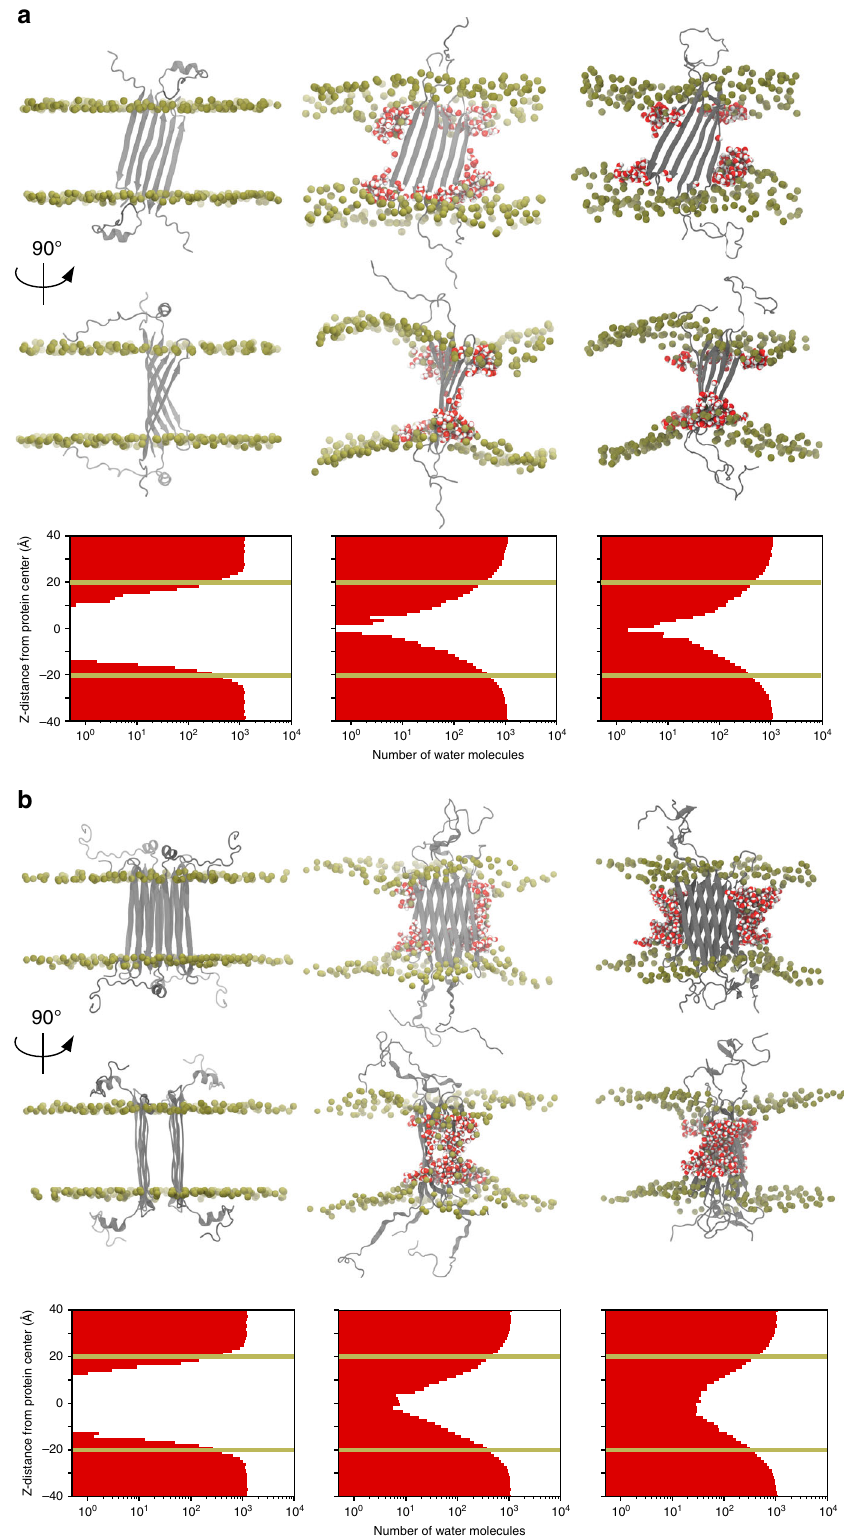
Fig. 5 MD simulations in DPPC membrane bilayer of A β (1-42). a tetramer and b octamer. The snapshots (two top rows) and water permeation pro fi les represented as histograms of the distribution of water molecules along the membrane normal (z) direction (bottom row) correspond to the initial coordinates (left), after 100 ns isothermal-isobaric NPT equilibrium simulation (middle), and after 500 ns canonical ensemble NVT simulation with 100 mV applied electric fi eld (right). Protein is shown in grey, DPPC headgroup phosphorous atoms are shown in tan, and water in red/white. The tan lines in the water permeation pro fi les represent approximately the membrane spanning